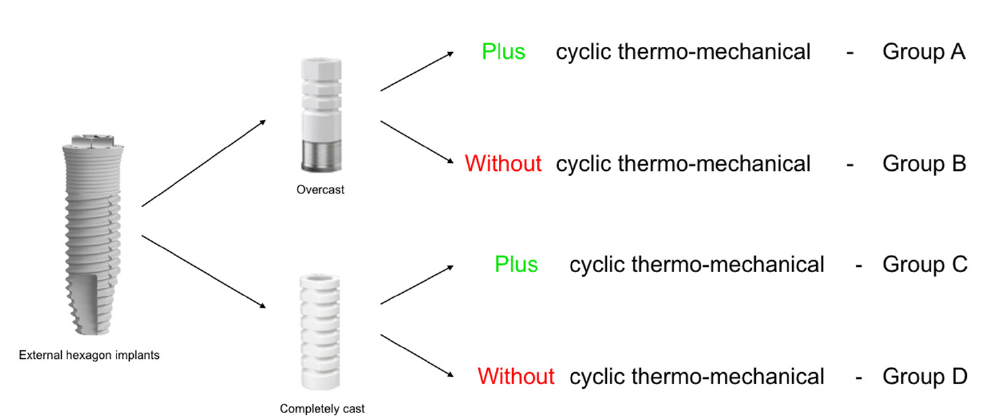
Figure 1. Experimental groups with different abutments.